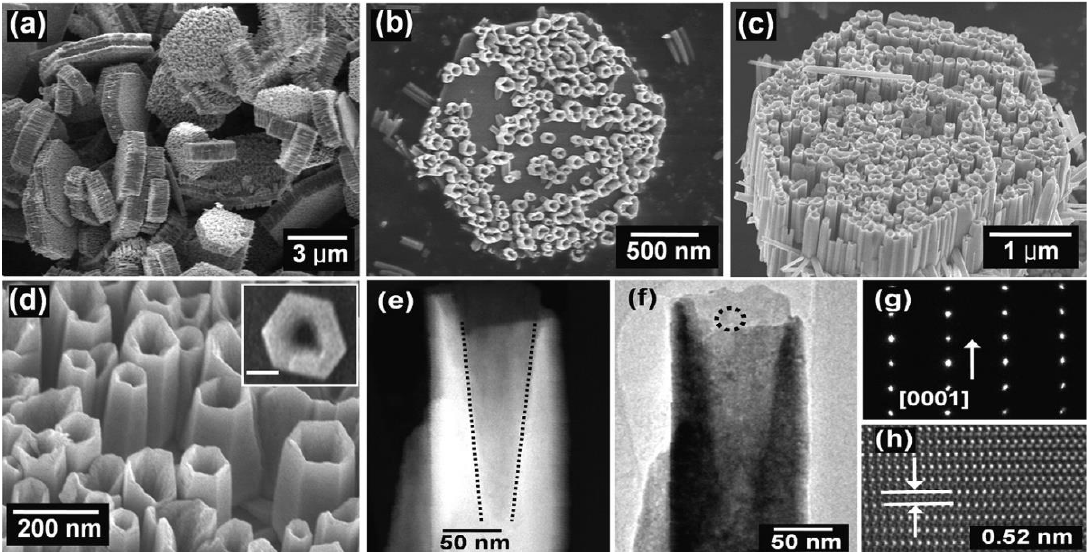
Figure 30. SEM images of hexagonal ZnO nanotubes/ZnAl:LDH heterostructures: ( a ) low magnification; ( b ) medium magnification (plan view); ( c ) medium magnification (oblique view); ( d ) high-magnification oblique view image of ZnO nanotubes grown on ZnAl:LDH; ( e ) HAADFSTEM image of a ZnO nanotube detached from a heterostructure; ( f ) TEM image of the ZnO nanotube; ( g ) SAED pattern; ( h ) HRTEM image of the point marked by the centre of the circle in ( f ). Republished with permission of © The Royal Society of Chemistry, from [723], Copyright (2009), permission conveyed through Copyright Clearance Center, INC. All rights reserved. In order to re-use permission must be obtained from the rightsholder.